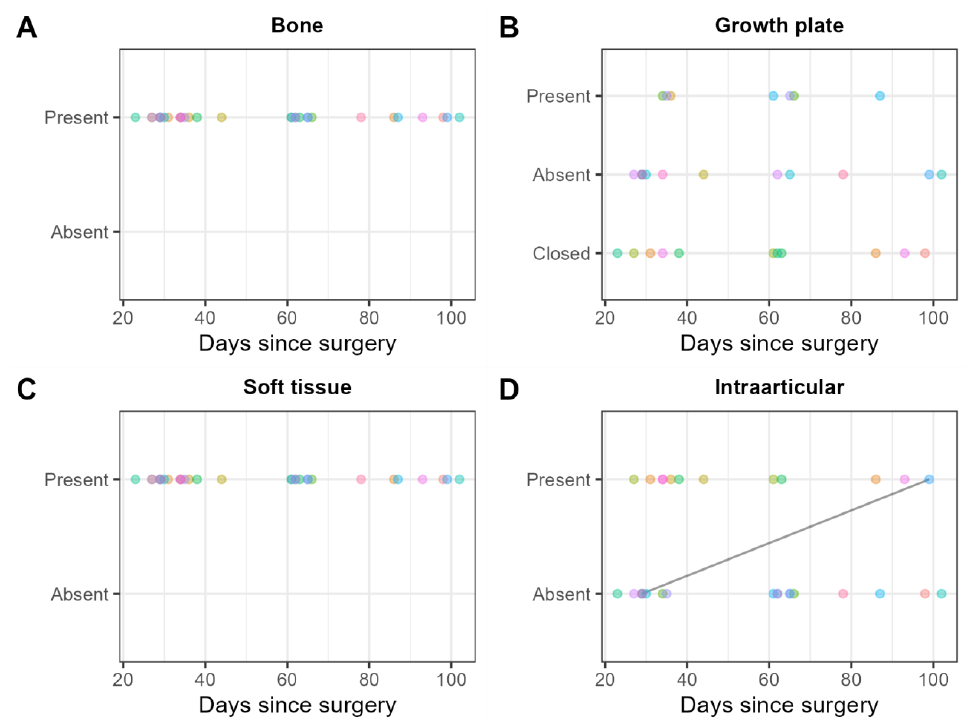
Figure 9. Consensus scores of the two readers on 30 MRI examinations for the presence/absence of gas locules ( A ) in the bone, ( B ) the growth plate, ( C ) the soft tissue, and ( D ) intraarticular. Each patient is represented by one color. Scores obtained on the same patient are shown in the same color. Solid black lines indicate within-patient changes over time.